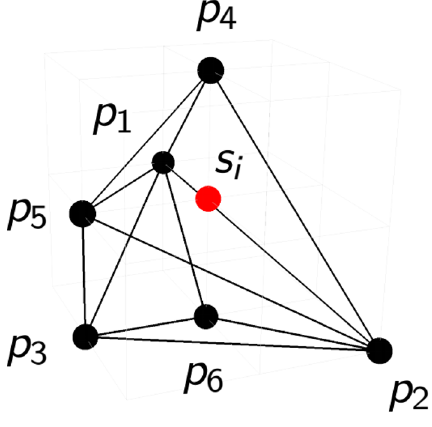
Figure 25 . Toric diagram for Model